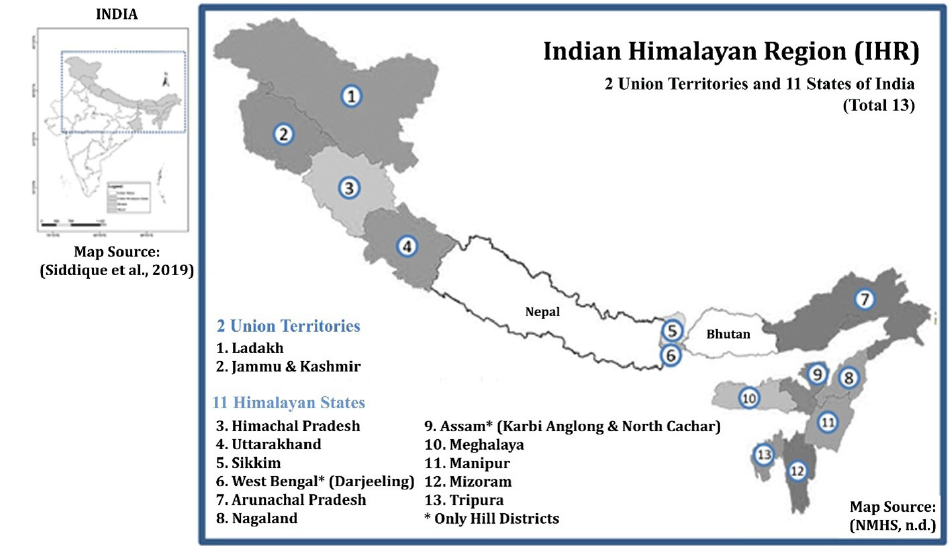
Figure 1. Study area: Indian Himalayan region; source: adapted from NMHS (2019) and Siddique et al.